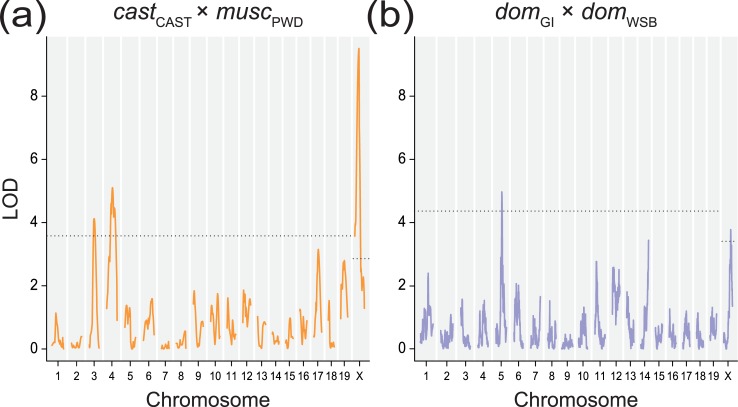
LOD plots for SC length QTL.Plots show significant QTL for SC length in the (a) castCAST × muscPWD cross on chromosomes 3, 4, and X and in the (b) domGI × domWSB cross on chromosomes 5 and X. Dashed line shows genome-wide significance level, α = 0.05.